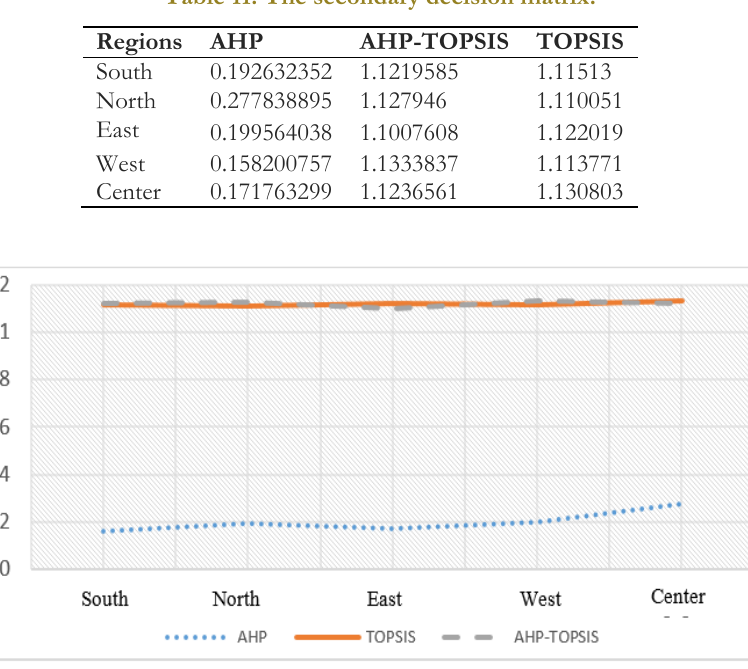
Fig. 4. Different results of the three methods used in the first